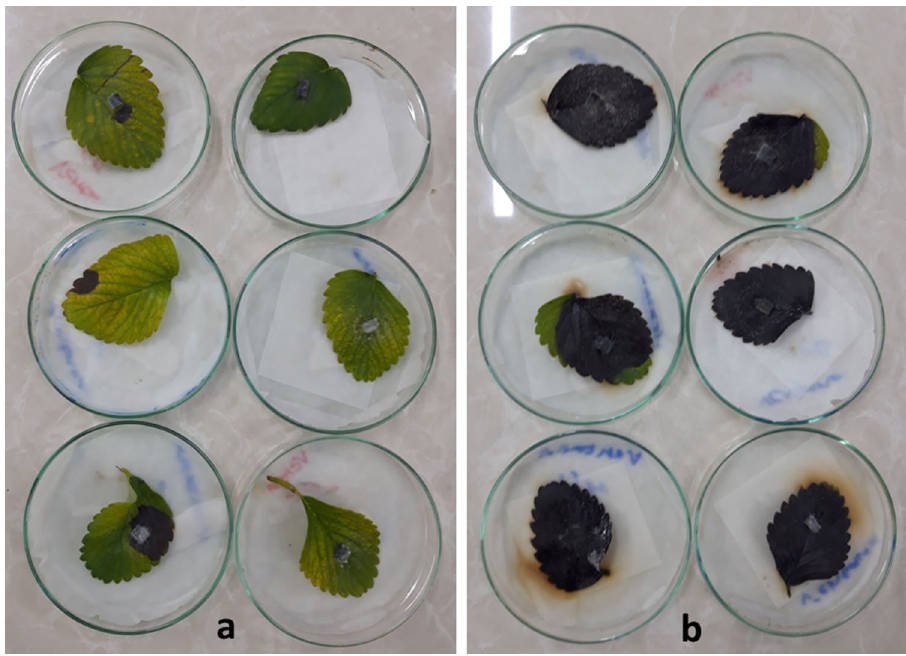
Figure 3. Bioassay of pFGC-TEF-d effects in control of L. theobromae in Ventana cultivar of strawberry leaves at 16 dpi. ( a ) Leaves transiently expressed pFGC-TEF-d as a treatment and ( b ) control leaves expressing empty plasmid ( pFGC